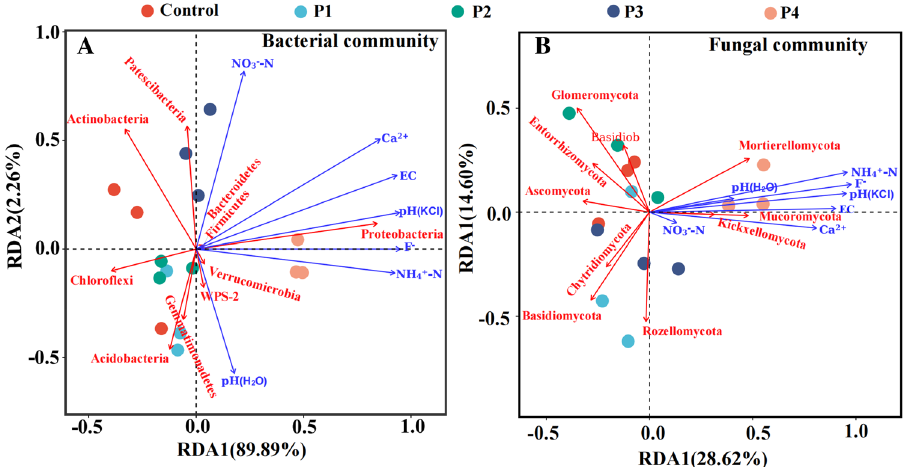
Figure 6. RDA (redundancy analysis) of environmental factors and bacterial ( A ) and fungal ( B )